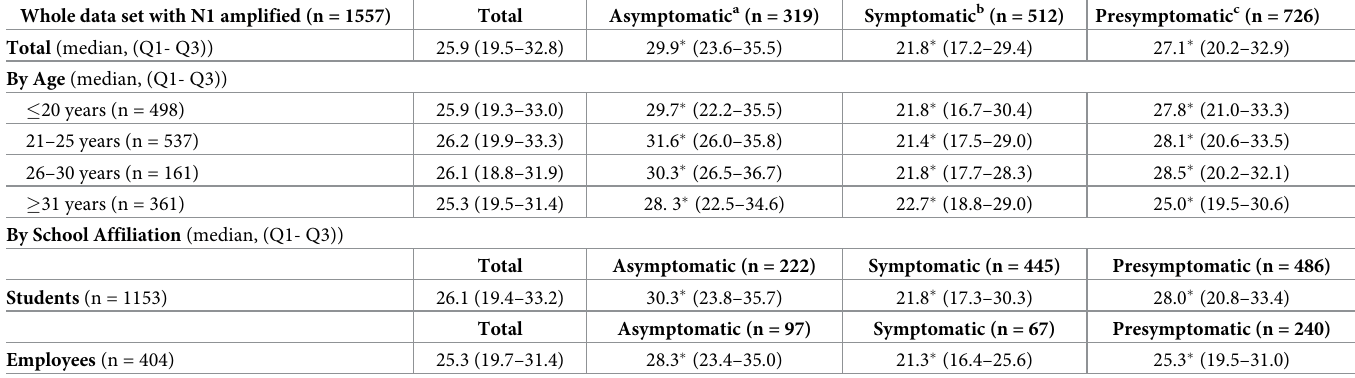
Table 2. General C T trends for the N1 gene